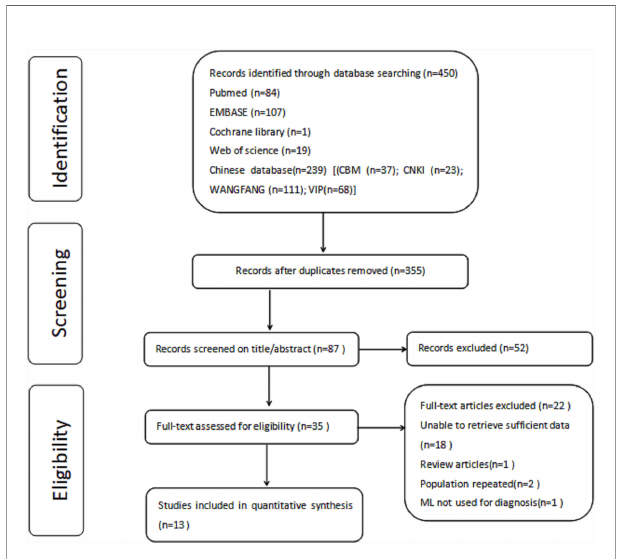
FIGURE 1 | Flow diagram of study selection for meta-analysis.